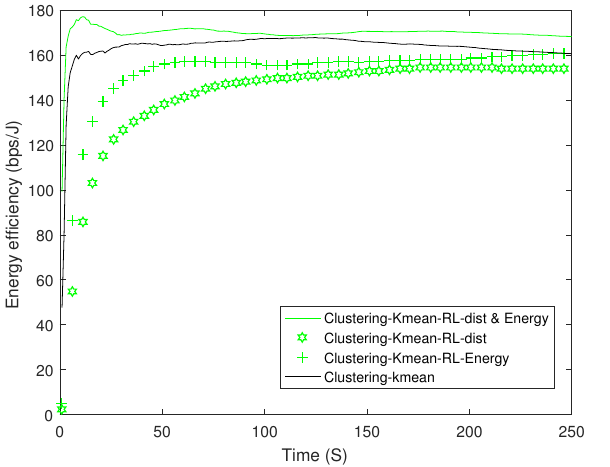
Figure 11. Energy efficiency of the reinforcement learning scheme. RL: Reinforcement Learning.